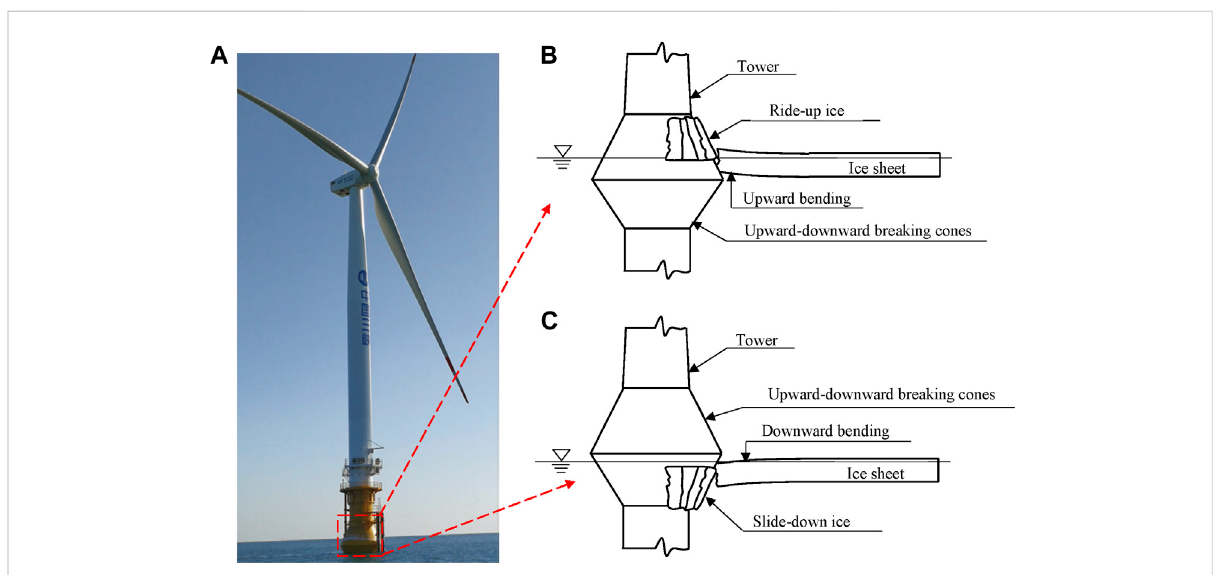
FIGURE 2 Ice-breaking cone on the wind turbine tower. (A) an offshore wind turbine with upward-downward breaking cones in the Bohai Sea; (B) a schematic diagram of a fl oating ice sheet interacting with the upward breaking cone at a high tide; (C) a schematic diagram of a fl oating ice sheet interacting with the downward breaking cone at a low